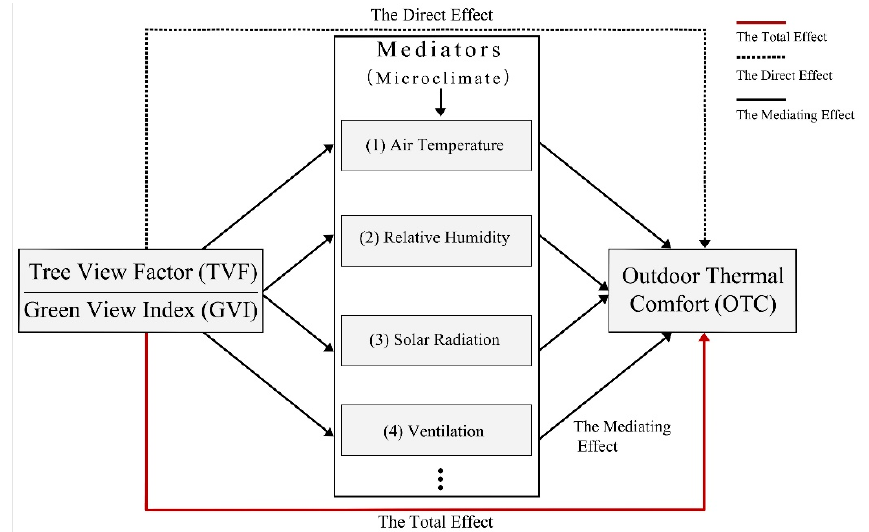
Figure 1. Hypothesized impact pathways of greenery on OTC.